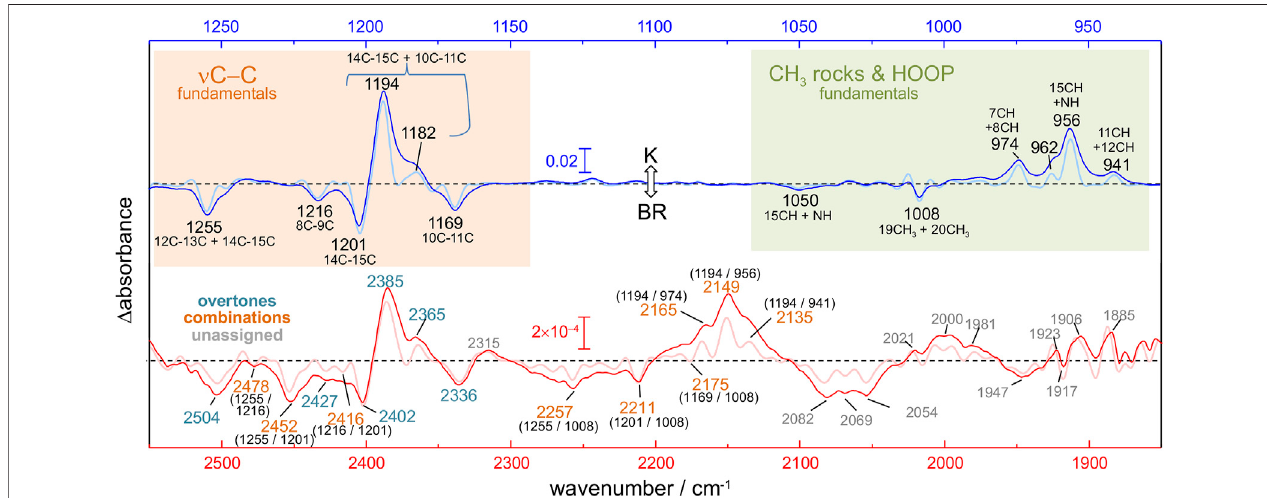
FIGURE2| K-BRdifferenceFT-IRspectrumat80 K.PositivebandscomefromvibrationsintheKintermediateandnegativebandsintheinitialBRstate.The fi gure compares fundamental transitions from retinal C-C stretches, CH 3 rocks and HOOP vibrations in the 1,275 – 925 cm − 1 region (blue trace), with potential overtones and combinations in the 2,550 – 1,850 cm − 1 region (red trace). The K-BR spectrum is also displayed after band narrowing with Fourier self-deconvolution (pale blue and pale red traces). For combination bands, the wavenumber of the two putative fundamental frequencies is given in brackets.